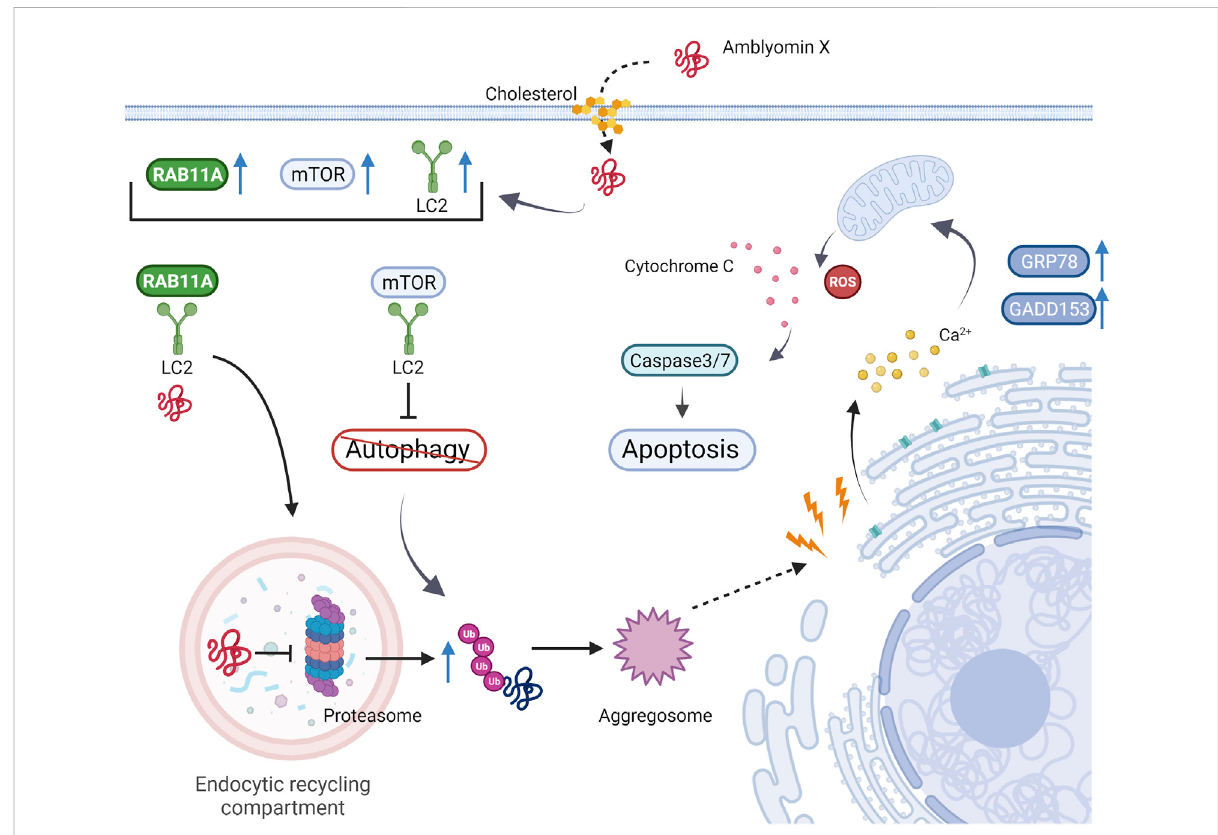
Mechanism of action of Amblyomin-X on tumor cells. The recombinant protein is internalized by endocytosis and transported by a dynein- assisted mechanism. Amblyomin-X inhibits proteasome activity, which results in aggresome formation via the non-exclusive ubiquitin pathway, ER stress,andmitochondrial dysfunction.Unlikeotherproteasomeinhibitors,Amblyomin-Xpromotesdynein-assisted autophagyinhibitionandmTOR localization. Therefore, the aggresomes are not cleared. These factors are crucial for apoptosis machinery to trigger a cell response. Figure created in